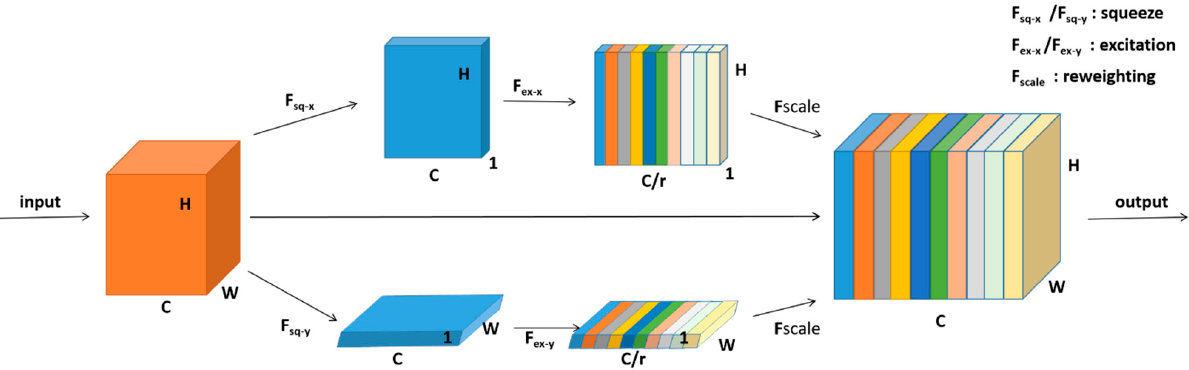
Figure 3. The details of the position-enhanced attention block ( C, W, H, r represent the number of channels, width, height and reduction ratio, respectively).